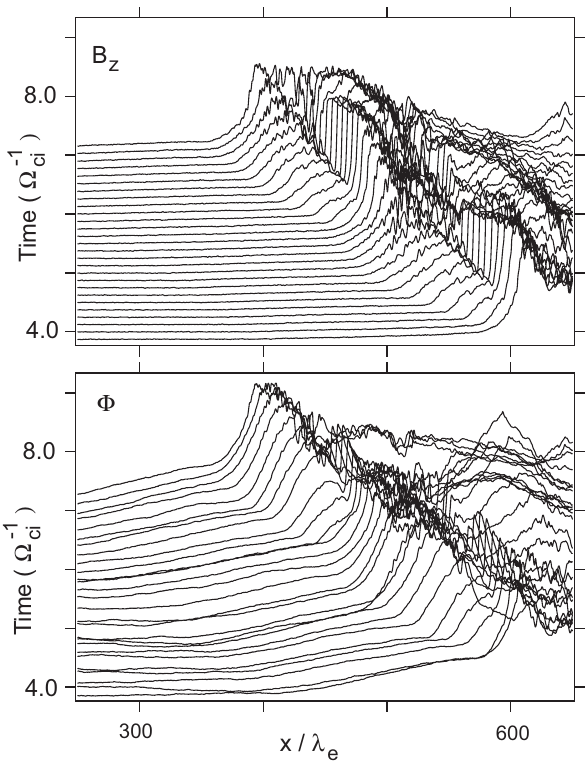
Fig. 4. Upper panel: Magnetic field B z component stacked in time for the ion to electron mass ratio 200 run. Lowe panel: Same for a single reflection cycle. Fig. 5. Upper panel: Magnetic field B z component stacked in time for the ion to electron mass ratio 1024 run with pickup protons in- cluded. Lower panel: Same for the cross shock potential 8